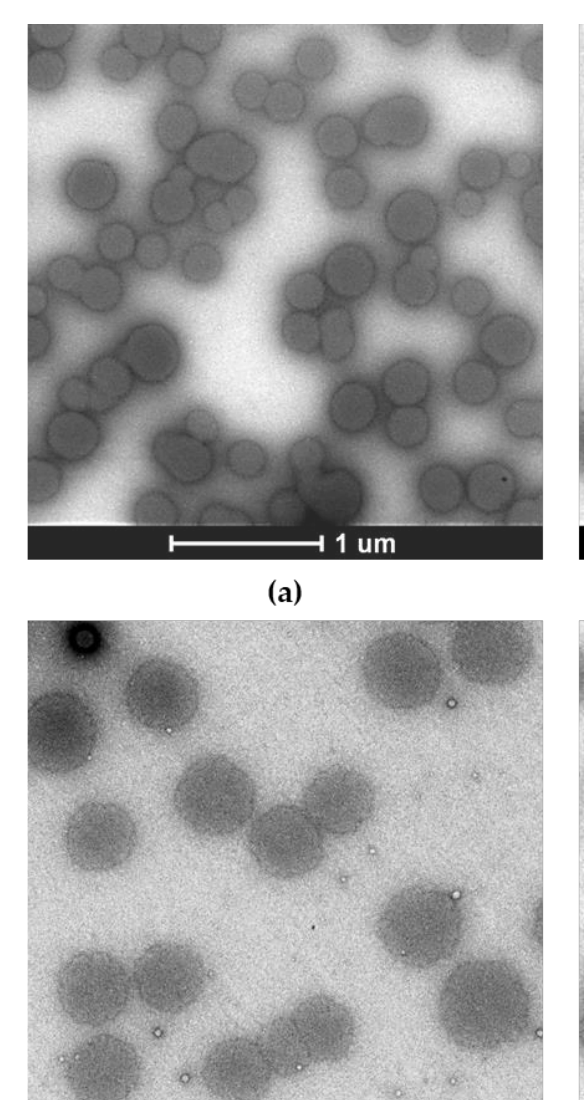
Table 2. Cont. Lyophilized, Cryoprotectant Data are presented as mean ± standard deviation of 3-16 independent sample batch replicates. *Non- significant difference compared to fresh SAAP-148-loaded nanogels. Abbreviations: OSA-HA = oc- tenyl succinic anhydride-modified hyaluronic acid; SAAP-148 = synthetic antimicrobial and antibi- ofilm peptide 148; PVA = polyvinyl alcohol; PDI = polydispersity index; ZP = zeta potential; EE = encapsulation efficiency; DL = drug loading.